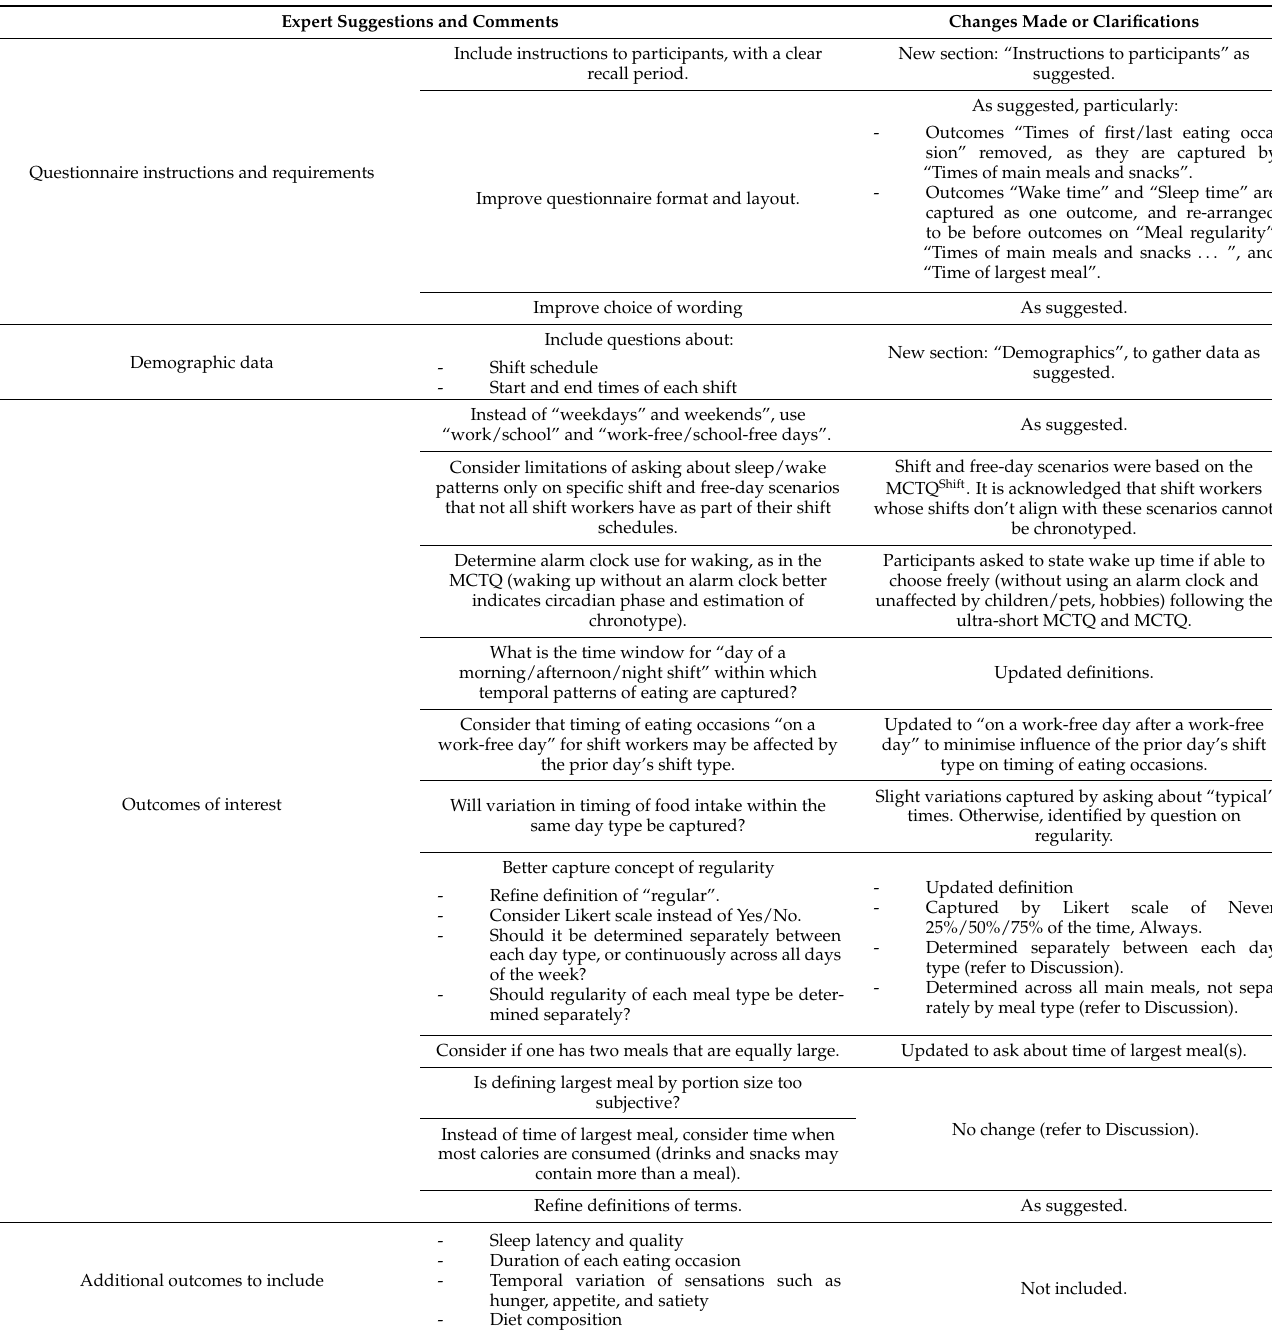
Table 3. Summary of comments provided by the expert panel and response by the research team in Round